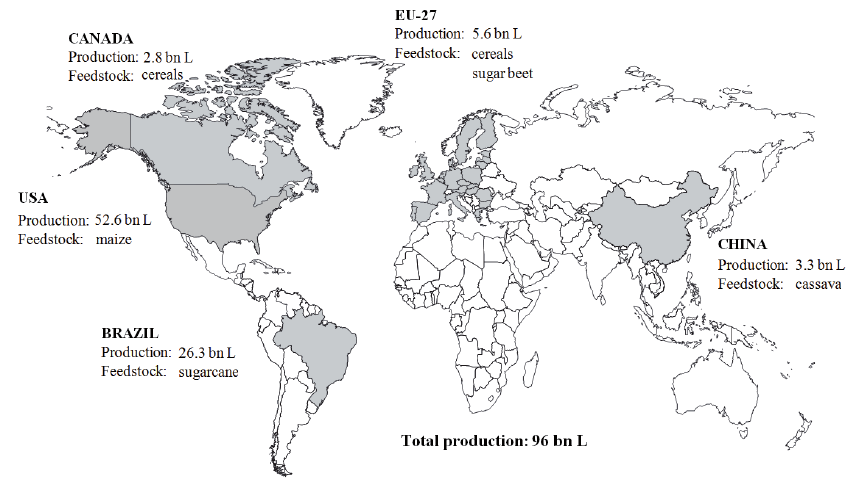
Fig. 2 – Word fuel ethanol production, average 2014-2016. Source: OECD/FAO (2017)